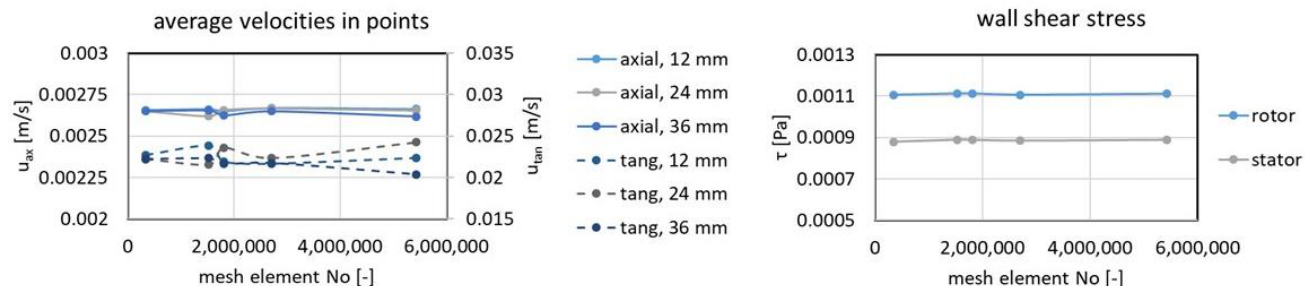
Figure 7. Average axial and tangential velocities in three points along the air gap ( left ) and wall shear stresses on the rotor and stator ( right ), resulting from the mesh independence study. Table 3. Adequate mesh sizing properties.